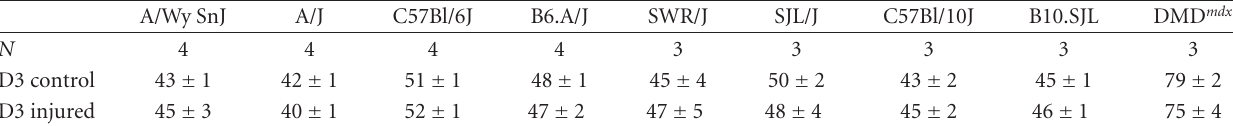
Table 2: Weights of TA muscles. Wet weights (in mg) of uninjured (right) and injured (left) TA muscles collected at D3 are given.